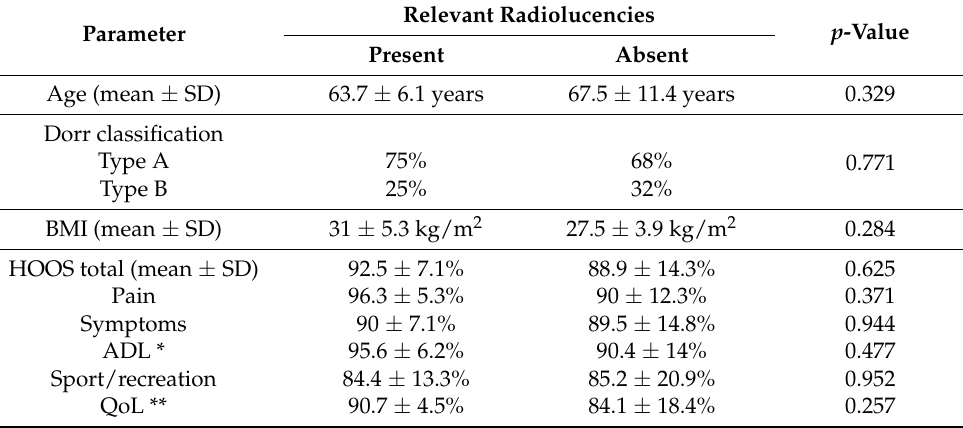
Table 3. Correlations between relevant radiolucencies and patient parameters.